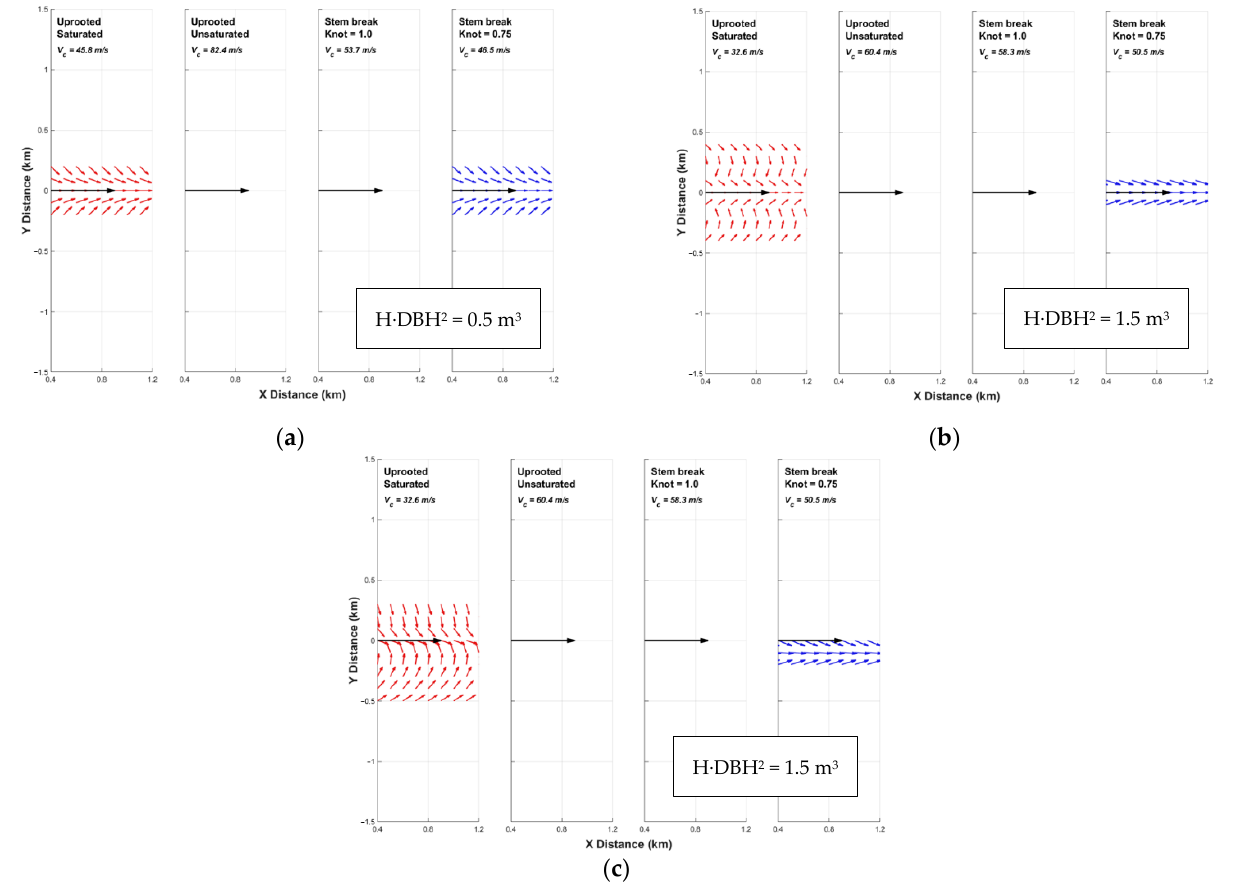
Figure 9. Treefall patterns with a translating vortex with V max = 52 m/s, G max = 3, R max = 240 m and φ = 0.7, ( a ) α = 0° and H·DBH 2 = 0.5 m 3 , ( b ) α = 0° and H·DBH 2 = 1.5 m 3 and ( c ) α = 30° and H·DBH 2 = 1.5 m 3 .